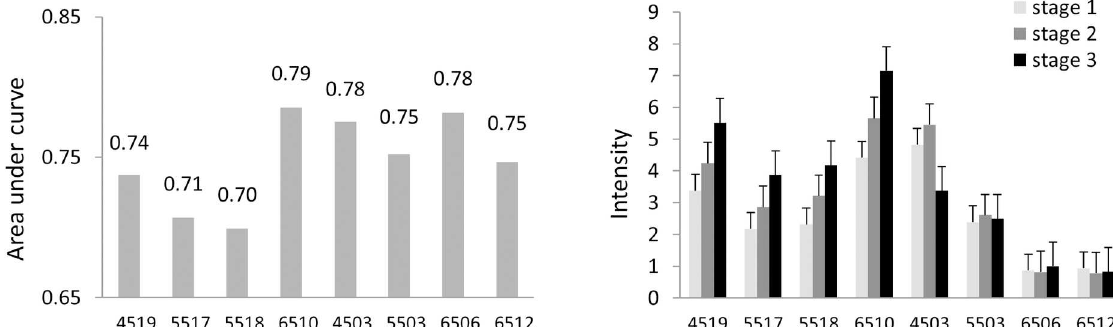
Fig 3. Breath analysis of molecular features. Breath samples were collected using a standard protocol from 50 patients. Chromatograms depicting the maximum intensity across all compensation fields at dispersion field (DF) settings of 45V, 55V or 65V were extracted. MF were defined based on identified peaks with an intensity greater than a threshold of 0.5 pA and designated with a four-digit number that included the DF setting as the first two, and order of separation as the second two digits. MF with differential ion intensities were isolated. The data represents the (A) the area under a receiver operator characteristic curve (AUC) for individual MF for the detection of cirrhosis; (B) MF peak intensity in samples from persons with different stages of disease. The data represents the mean and standard deviation for MF peak ion intensity in pA.